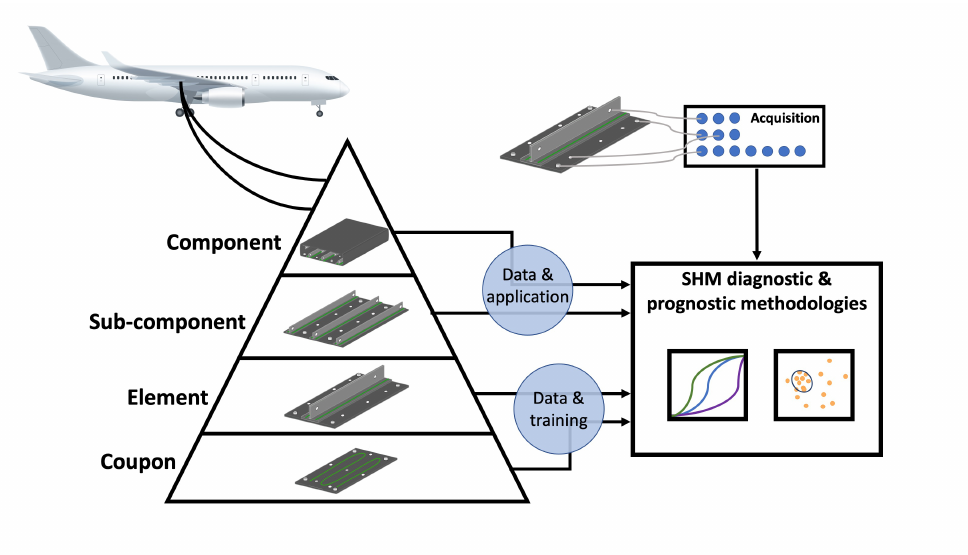
Figure 1. Structural health monitoring (SHM) pyramid approach for upscaling composite aircraft structures based on the building-block approach for structural